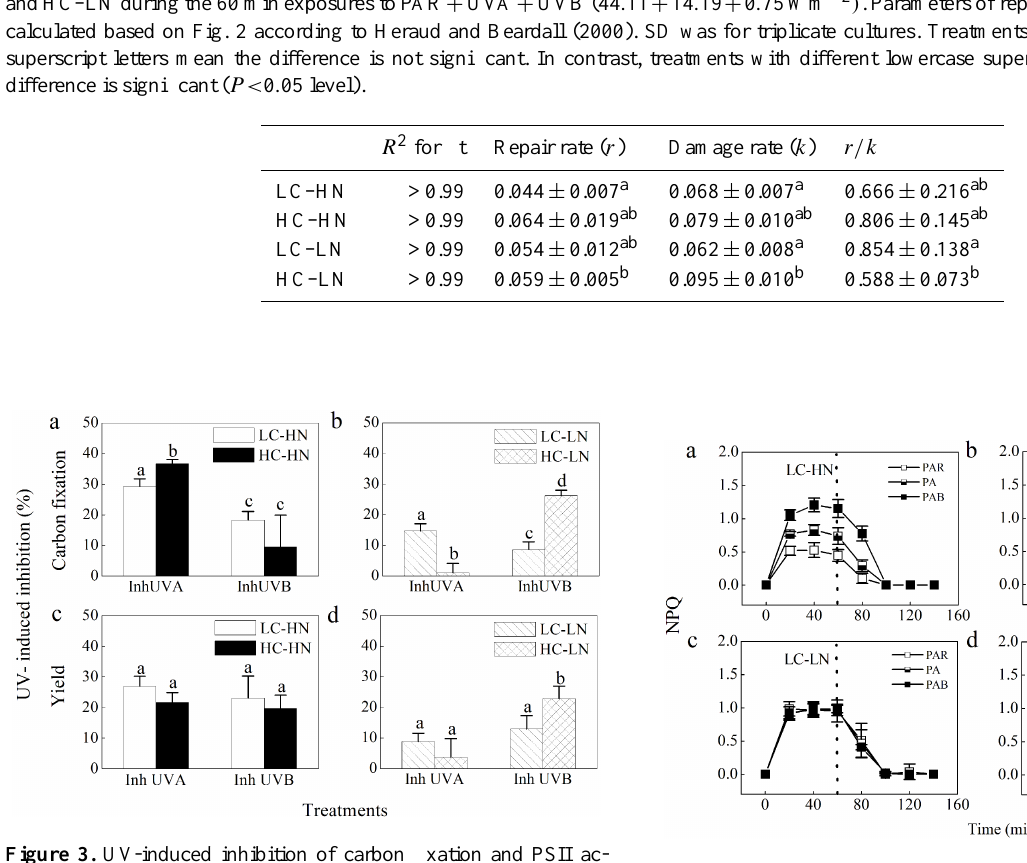
Figure 4. Non-photochemical quenching (NPQ) of P. tricornu- tum under different treatments. NPQ of P. tricornutum grown at ambient (390µatm, LC) or elevated CO 2 (1000µatm, HC) under (a, b) NO − -replete (110µmolL − 1 , HN) and (c, d) NO − -limited -limited 3 3 3 (10µmolL − 1 , LN) conditions when exposed to PAR, PAR + UVA (PA) and PAR + UVA + UVB (PAB) for 60min and another 80min under the growth light level, respectively. The irradiance intensities under solar simulator or growth light were the same as mentioned above. Vertical bars means ± SD, n =